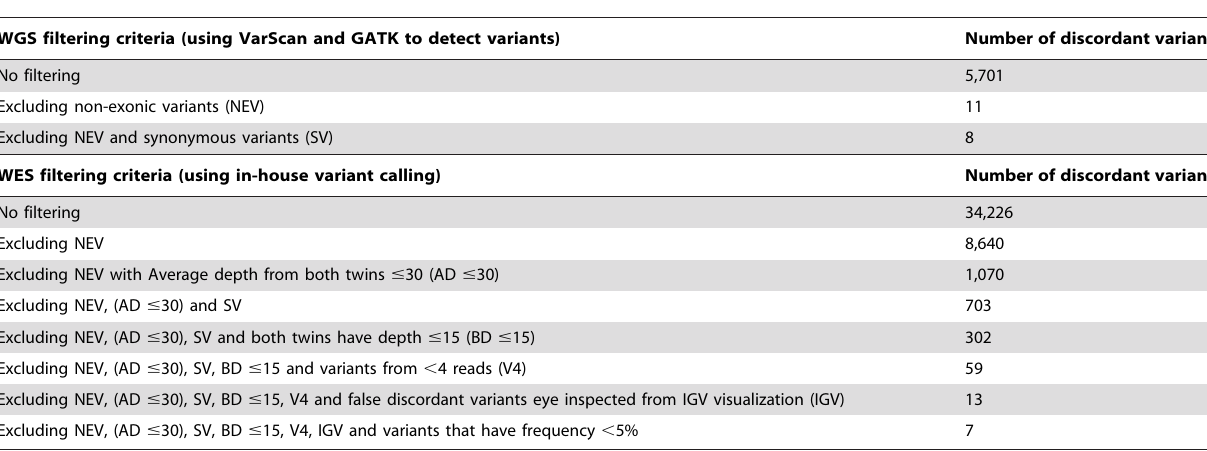
Table 2. Number of discordant variants after applying different exclusion criteria for WGS and WES experiments.